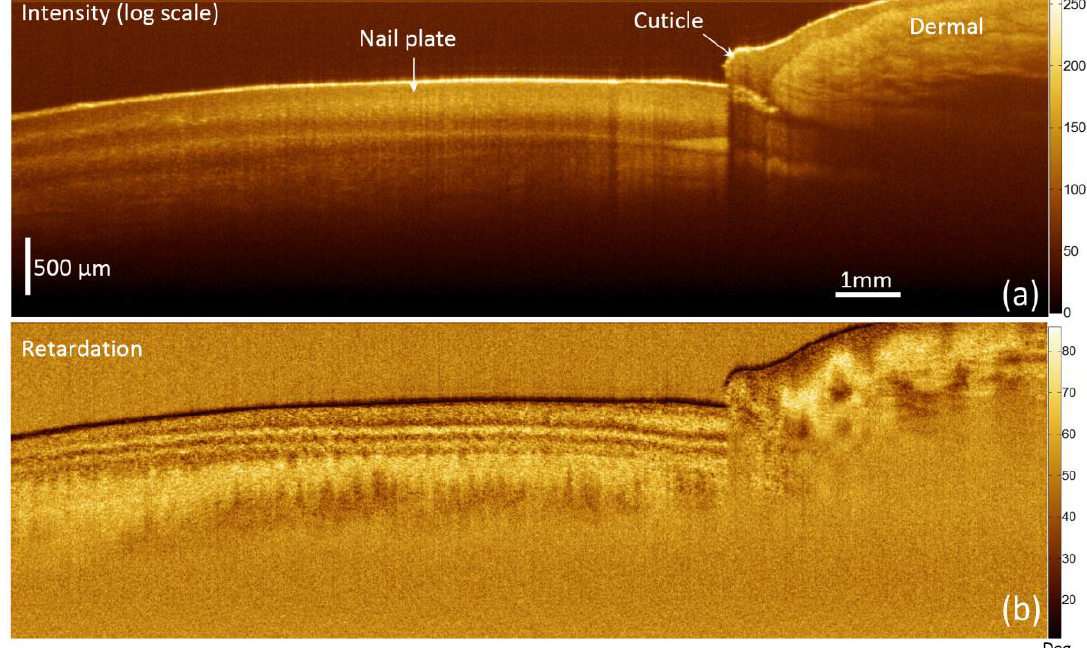
Figure 3. PSOCT imaging of fingernail; Intensity ( a ) and retardation ( b